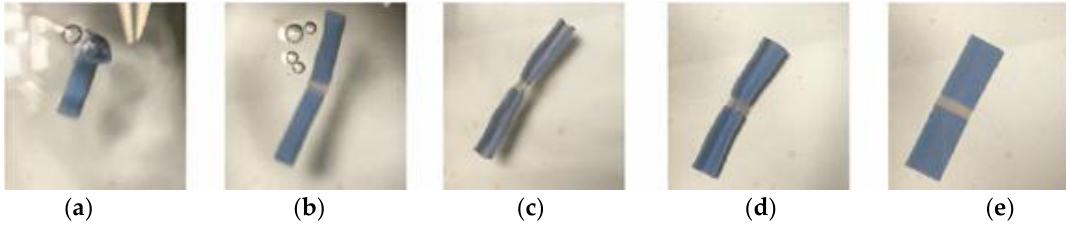
Figure 19. Method 1—the sequence of unfolding for the 0.3 mm sample from ( a ) Folded specimen was put in water bath and started to unfold; ( b ) Unfold along folding line 1; ( c , d ) Unfold along folding line 2; ( e ) Fully unfolded specimen.